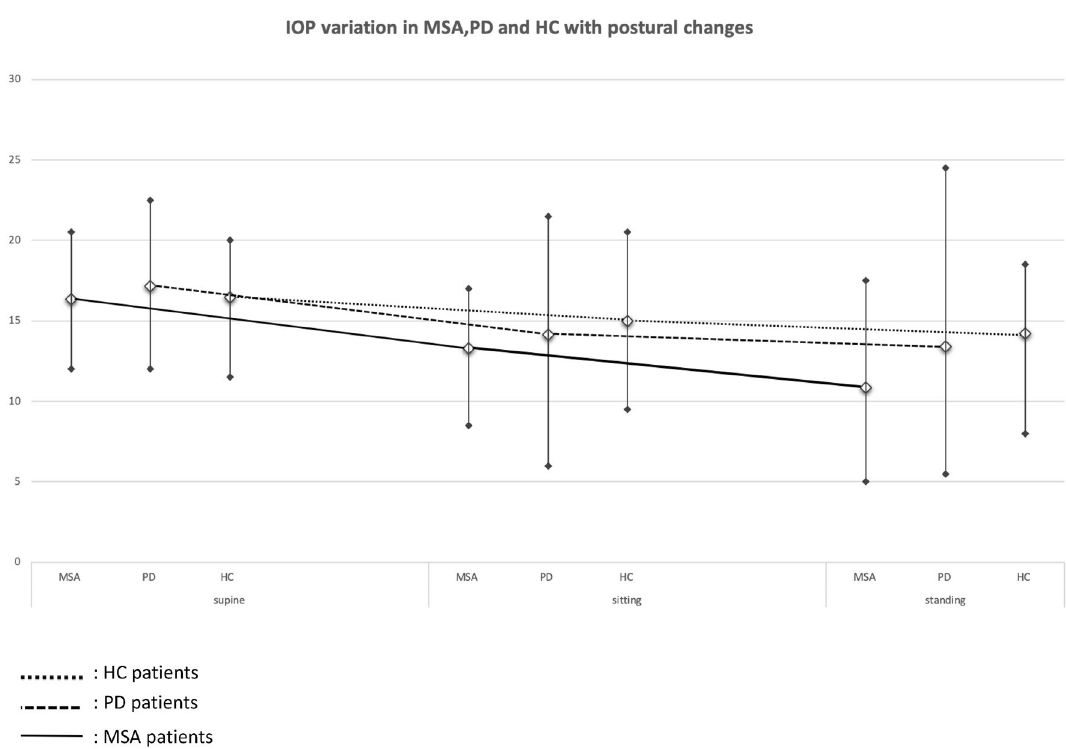
Figure 1. Intraocular Pressure variation (in mmHg) in Multiple System Atrophy, Parkinson’s Disease patients and Healthy Controls with postural